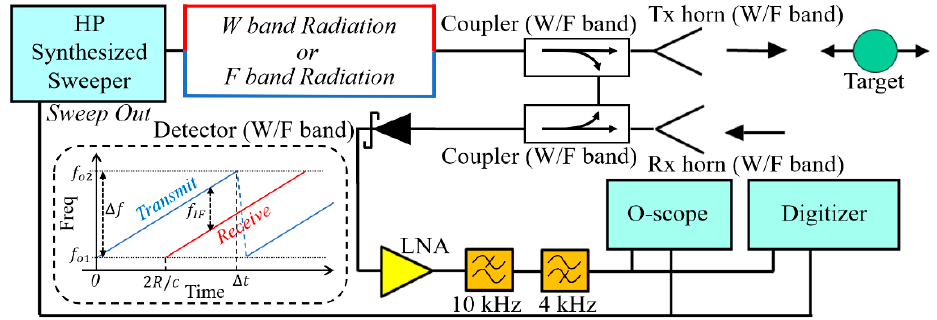
Figure 2. Schematic representation of the prototype W/F-band swept-FM radar system.